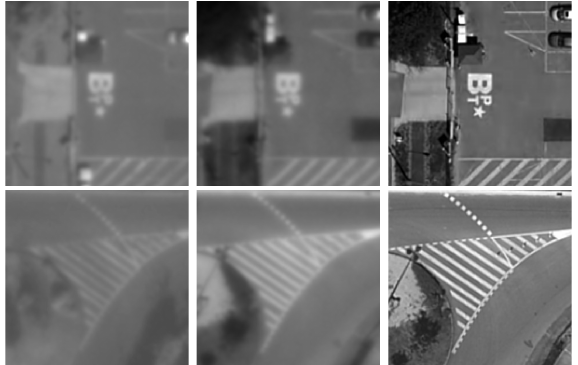
Figure 1 Image data examples. Left: Réal Pléiades Neo L1A, upsampled. Center: Simulated Pléiades Neo L1A, upsampled. Right: HR simulated target for super resolution